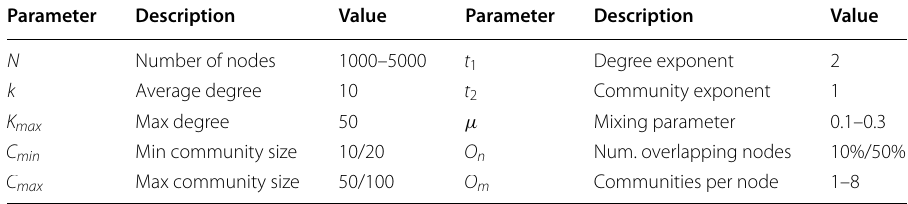
Table 1 Parameter ranges used for the generation of LFR synthetic networks Parameter